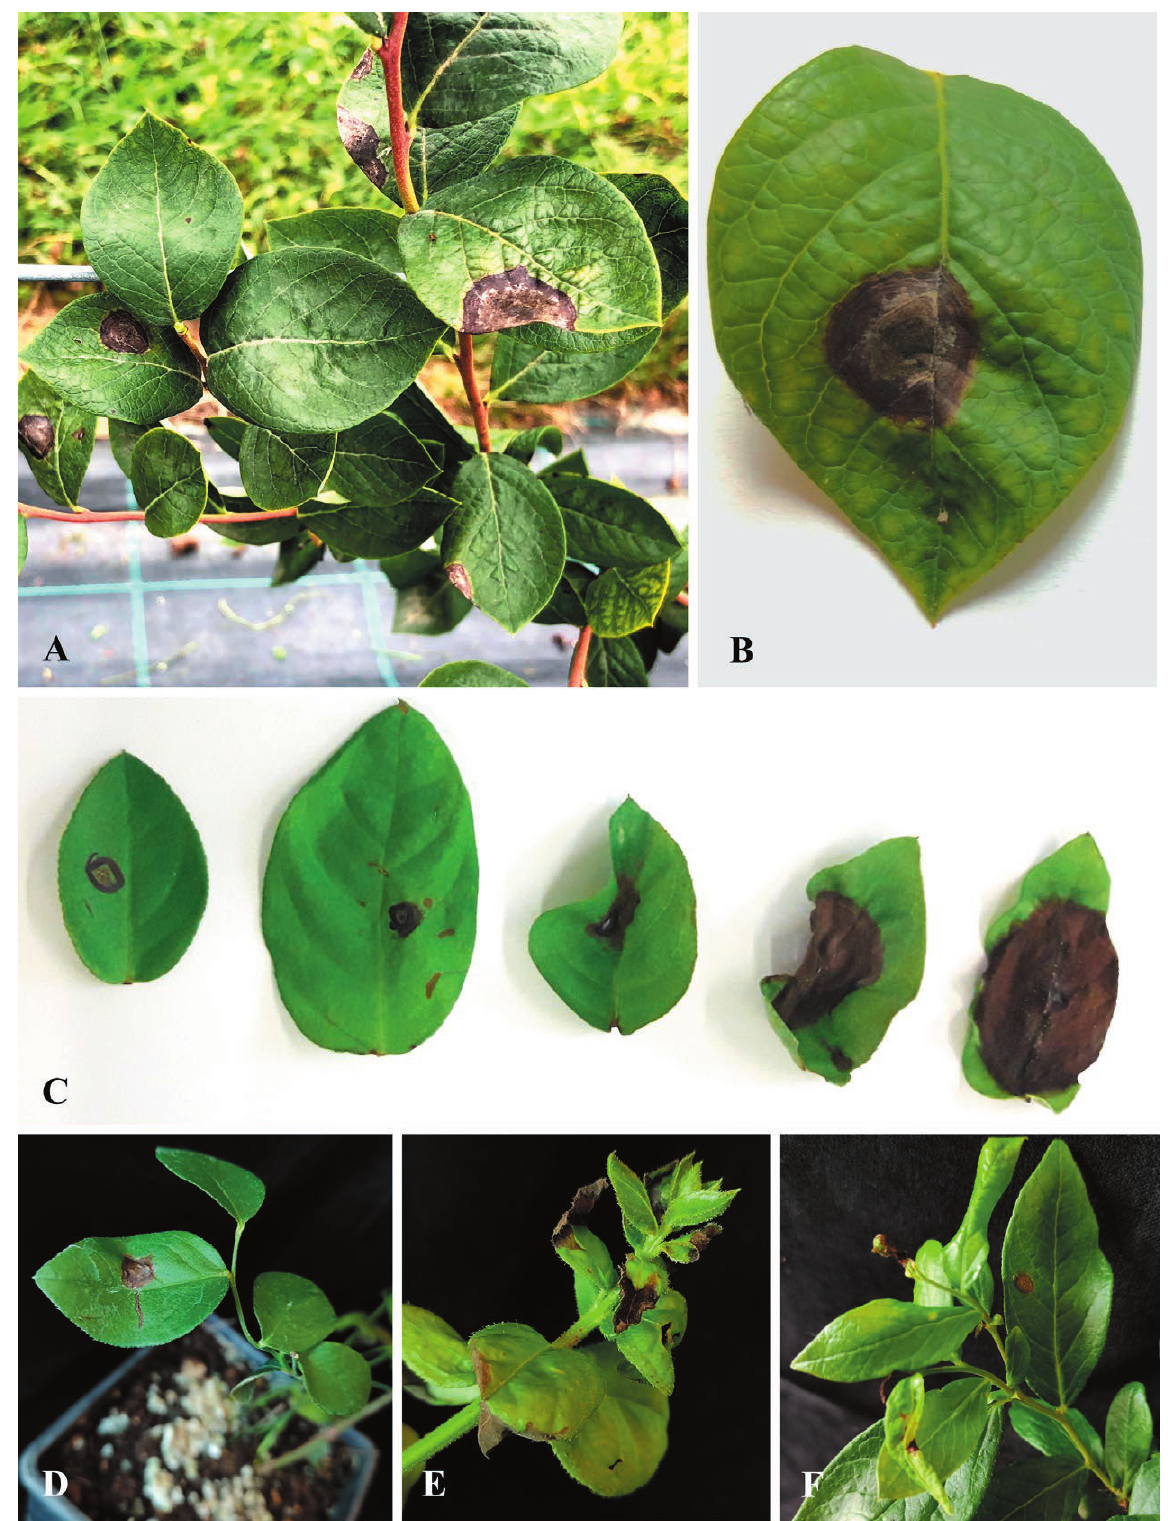
Figure 1. Leaf anthracnose (A and B) of Vaccinium corymbosum ‘Blue Ribbon’ in the field, and leaves of ‘Last Call’ at different necrotic stag- es after inoculation (C). Anthracnose developed after inoculations on ‘Last Call’ wounded (D and F) and unwounded (E) attached